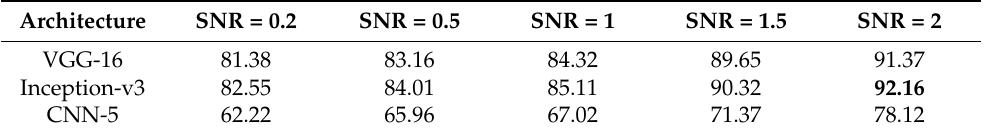
Table 1. Dependence of the proportion of correct recognitions on the signal-to-noise ratio (SNR). Architecture